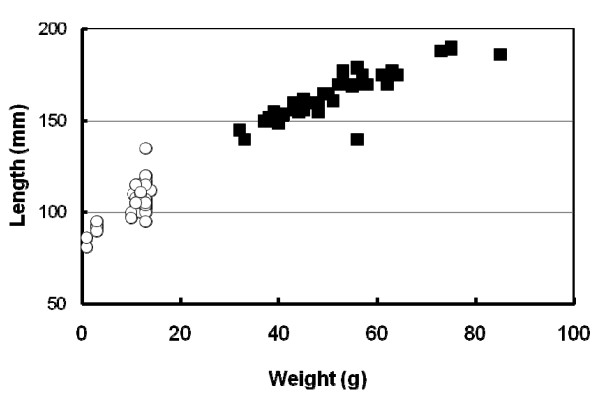
Fish sample populations for precocity and non-precocity. Precocious fish (empty circles) and non-precocious fish (full squares) were weighed and measured. Fish (25 of both precocious and non-precocious) were sampled on 15 Jan 2003. The difference in weight (using an unpaired t-test) and length (using a Mann Whitney test) in the two populations were both shown to be extremely significant (P < 0.0001).